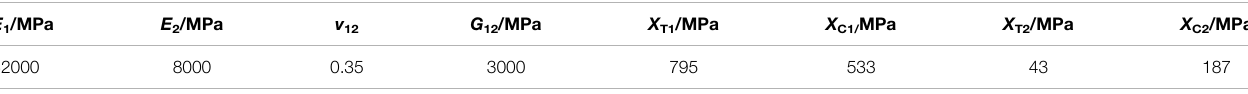
TABLE 2 | Mechanical properties of the GFRP material.